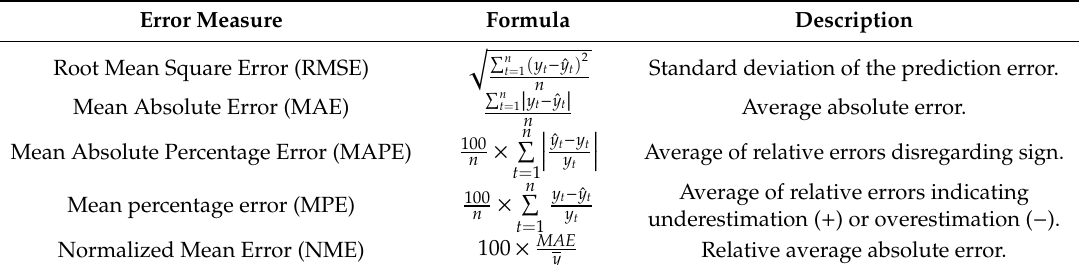
Table 8. Performance measures. One-step-ahead forecast at time of day t using all previous relevant information is denoted by ˆ y t ; y represents the mean of the series, and n is the number of available observations in the